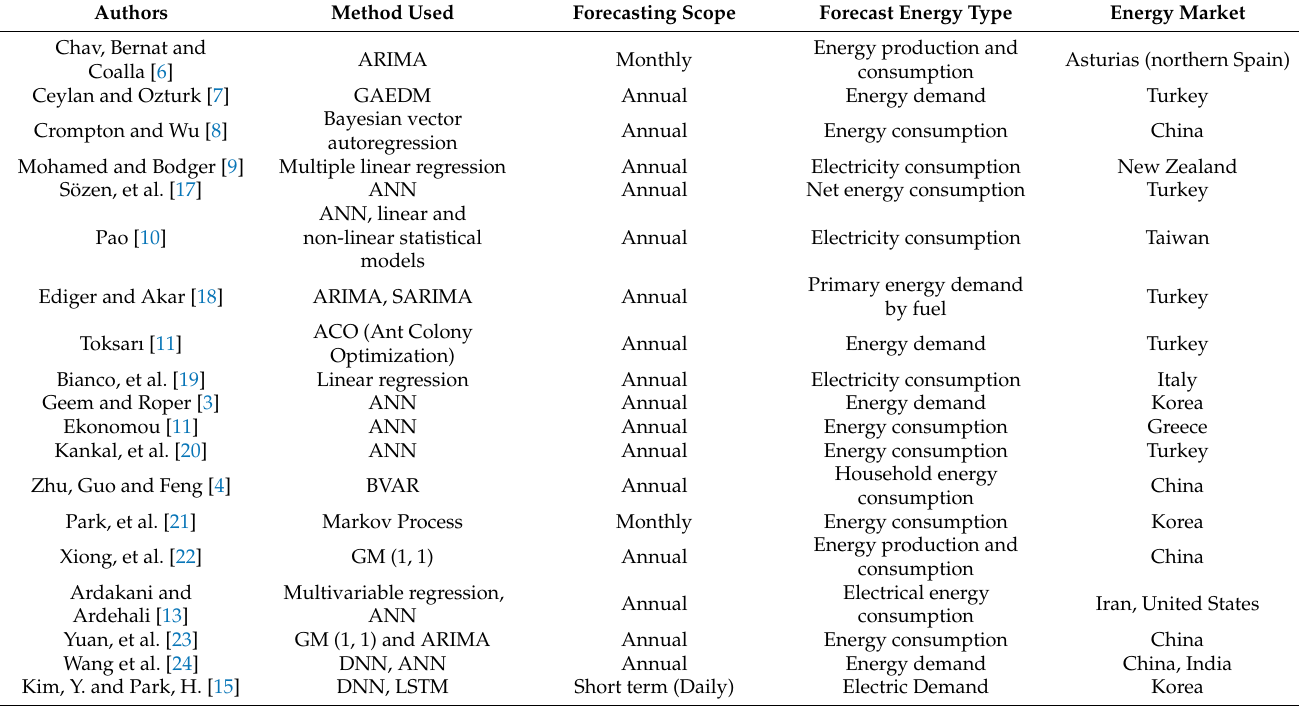
Table 1. List of reviewed